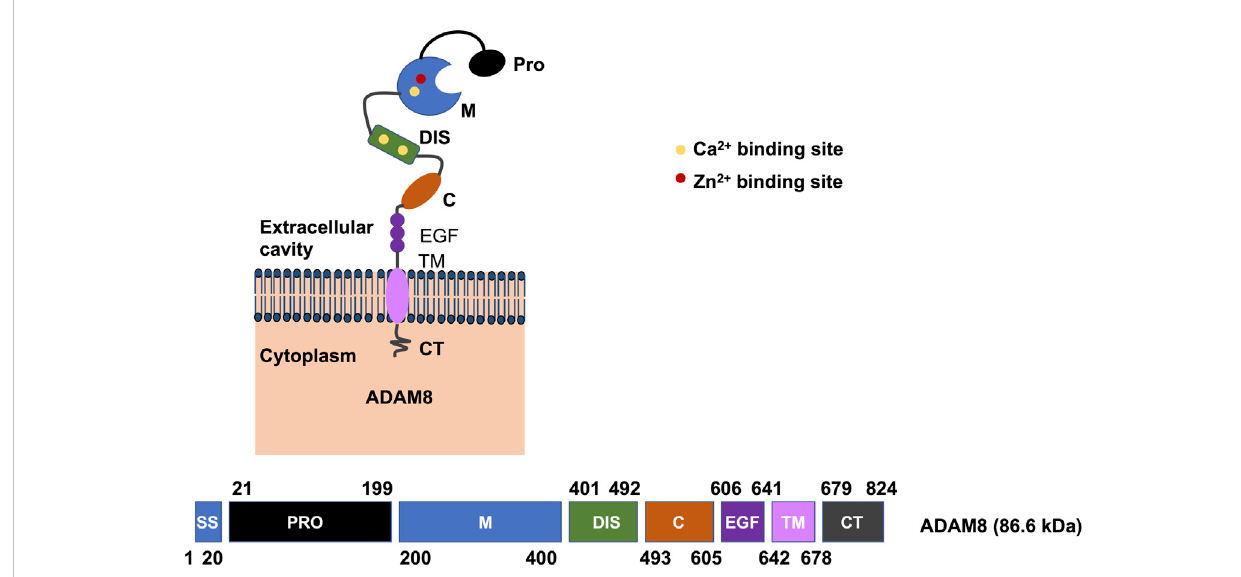
FIGURE 3 Illustration of the domains of human ADAM8. On the plasma membrane, the active human ADAM8 comprises a motif associated with Zn 2 + ions within the catalyticdomain, that is, essential for the functionality (top image). There is also a motif for binding of a Ca 2+ ion in the M domain and even two moreintheDISdomain.Proteindomainsareschematicallydrawn,andaminoacidpositionsareindicatedbelow(bottomimage).Thedomainsaredrawn in their sequential order by providing the amino acid numbers for the domains (bottom image). Domain name abbreviations are as follows: C, cysteine-rich; CT , cytoplasmic tail; DIS, disintegrin-like; EGF, epidermal growth factor-like; M, metalloproteinase; Pro, prodomain; SS, signal sequence and TM